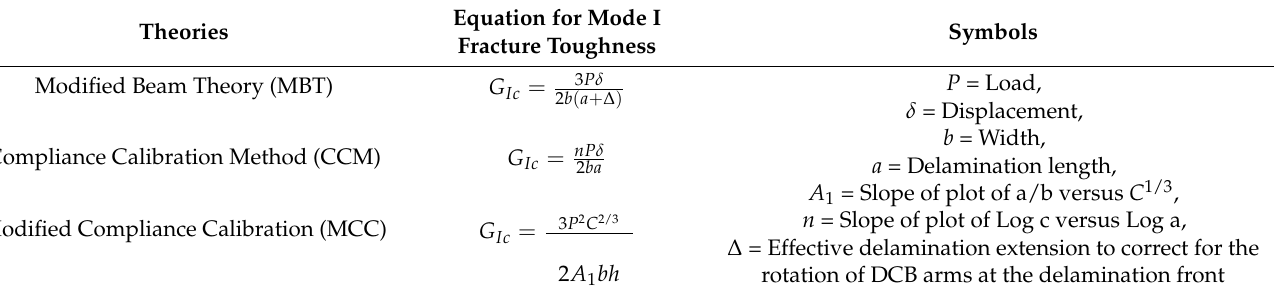
Figure 4. Experimental set up for the DCB specimen. Table 1. G IC prediction using different theories